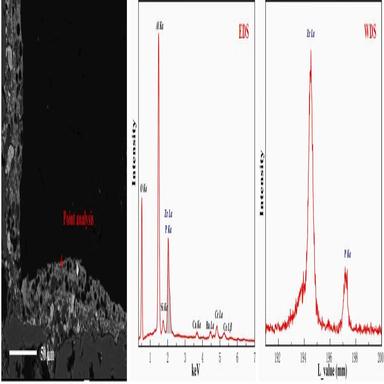
Detailed results of EDS and WDS point analyses in the washcoat outer layer of C1.